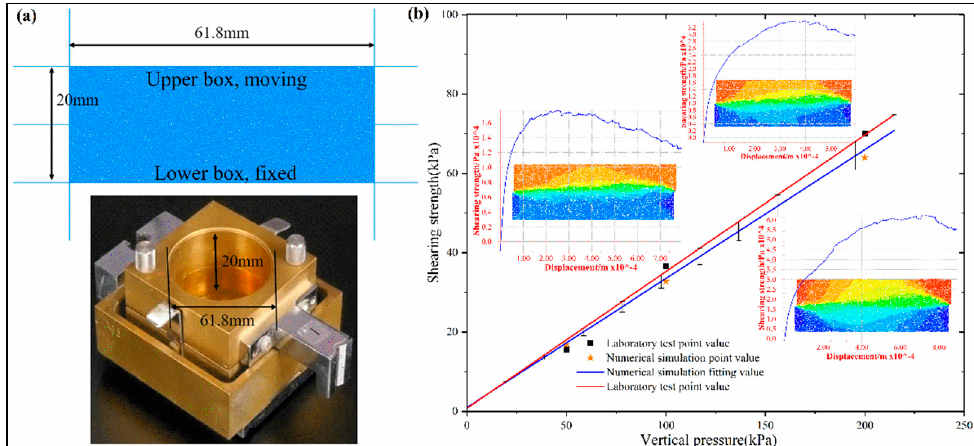
Figure 5. Parameter calibration process and results. ( a ) Numerical model of the direct shear test; ( b ) Parameter calibration result.